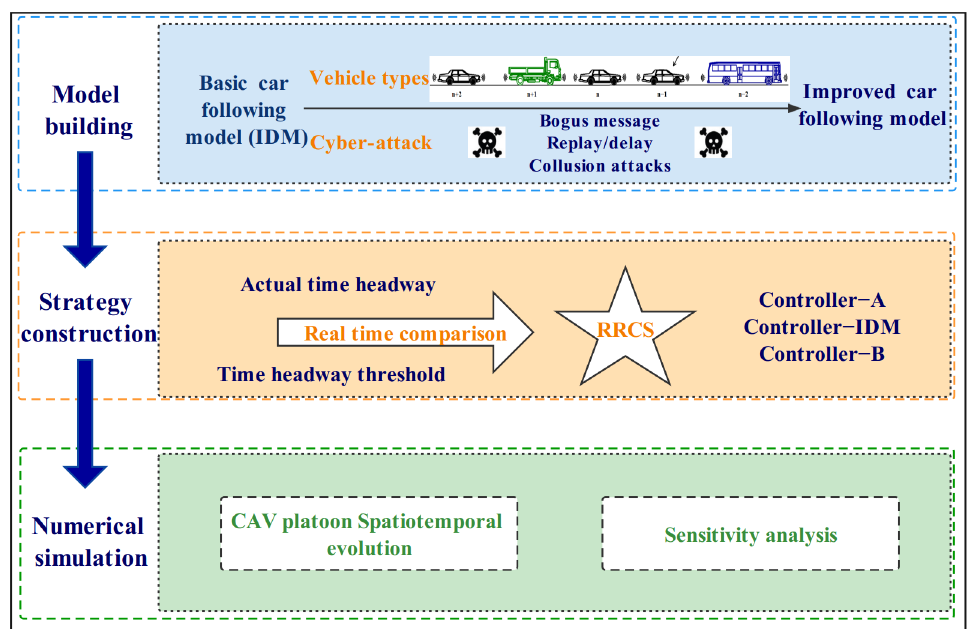
Figure 2. Architecture for exploring the impacts of RRCS on mixed CAV